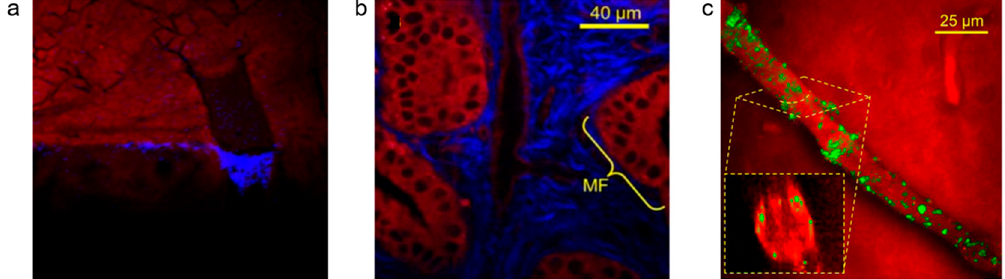
Figure 8. Multimodal imaging of nanoparticle delivery in tissue. ( a ) Porated skin incubated with deuterated methyl methacrylate nanoparticles. Image contrast derived from coherent anti-Stokes Raman scattering (CH 2 , 2855 cm − 1 , red) and stimulated Raman scattering (CD 2 nanoparticles, 2120 cm − 1 , blue). Reproduced with permission from [98], Copyright Elsevier, 2014; ( b ) Planar cross section through a sample of mouse gall bladder. A mucosal fold (MF) is indicated. Image contrast derived from two photon fluorescence (endogenous fluorophores, red) and second harmonic generation (collagen, blue). Reproduced with permission from [102], Copyright John Wiley and Sons, 2012; ( c ) Cross-section of a mouse-brain blood vessel following incubation with deuterated quaternary ammonium palmitoyl glycol chitosan nanoparticles. Image contrast derived from epi-detection CARS microscopy of lipid (CH 2 , 2845 cm − 1 , red) and nanoparticles (C–D, 2100 cm − 1 , green). Reproduced with permission from [107]. Copyright Springer Nature, 2016.